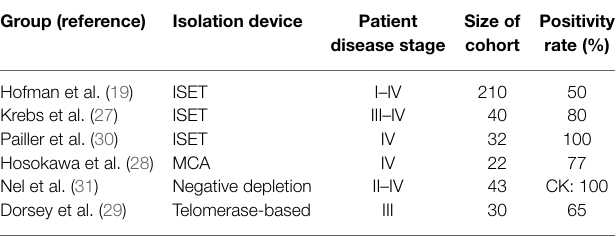
TABLE2 | CTCdetectioninpatientswithNSCLCusingEpCAM-independent assays